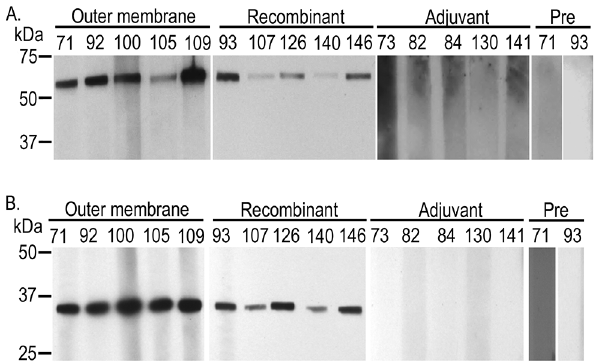
Fig 3. Western blots demonstrating IgG response to recombinant proteins in vaccinates. Animals immunized with purified outer membranes (Outer membrane) or recombinant proteins (Recombinant) had an antibody response to (A) recombinant AM854 at 54kD and (B) recombinant AM936 at 36kD. There was no response to these proteins in animals that received only adjuvant (Adjuvant). Similarly, there was no response prior to immunization (Pre). Results for all animals prior to immunization were similar, thus one representative animal from each group is shown. All western blots were done using a serum dilution of